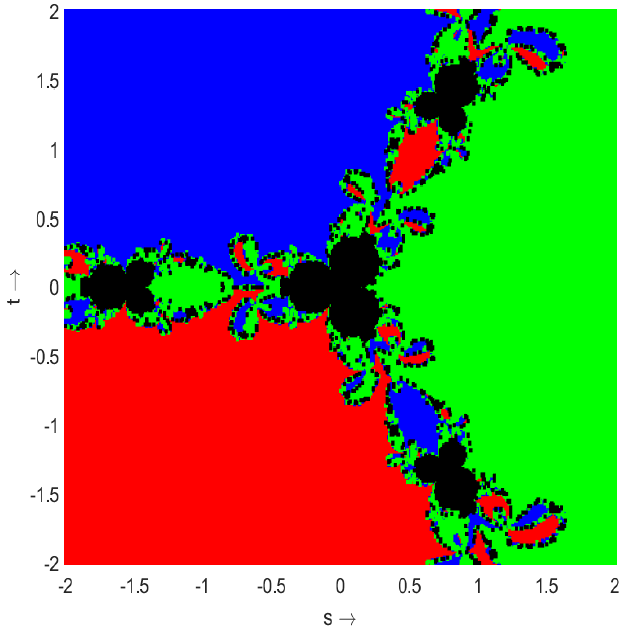
Figure 5. Dynamics of the method (3) associated with BA of Example 5. In Figure 6 (corresponding to Example 5), the red region is the set of all initial points from which the iterate (4) converges to ( − 1/2, − initial points from which the iterate (4) converges to ( − 1/2,